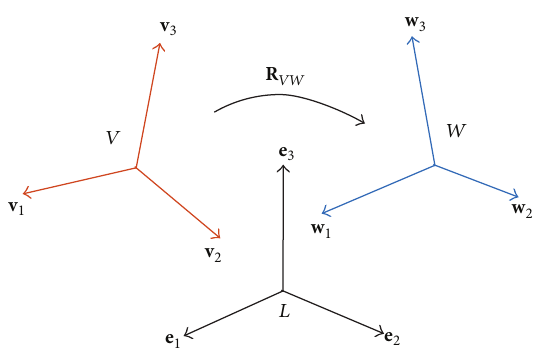
Figure 2: Relative orientation of two submolecular domains. Orthonormal eigenvectors for domains V and 𝑊 and standard basis for the laboratory system L . Rotation matrix R 𝑉𝑊 transforms eigenvectors from domain 𝑉 into domain 𝑊 . Note that eigenvectors share the same coordinate system origin. For better visualization, eigenvectors are displayed as if they had different